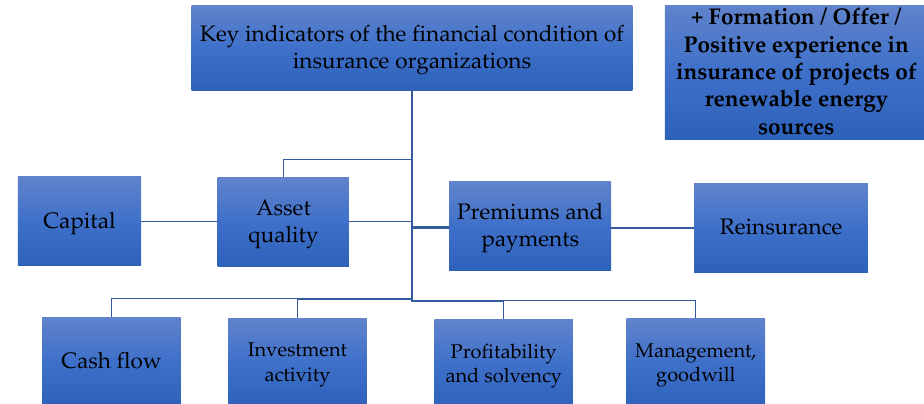
Figure 4. The key indicators of the financial condition insurance organizations—participants of the insurance program for renewable energy sources. Source: authors own design.